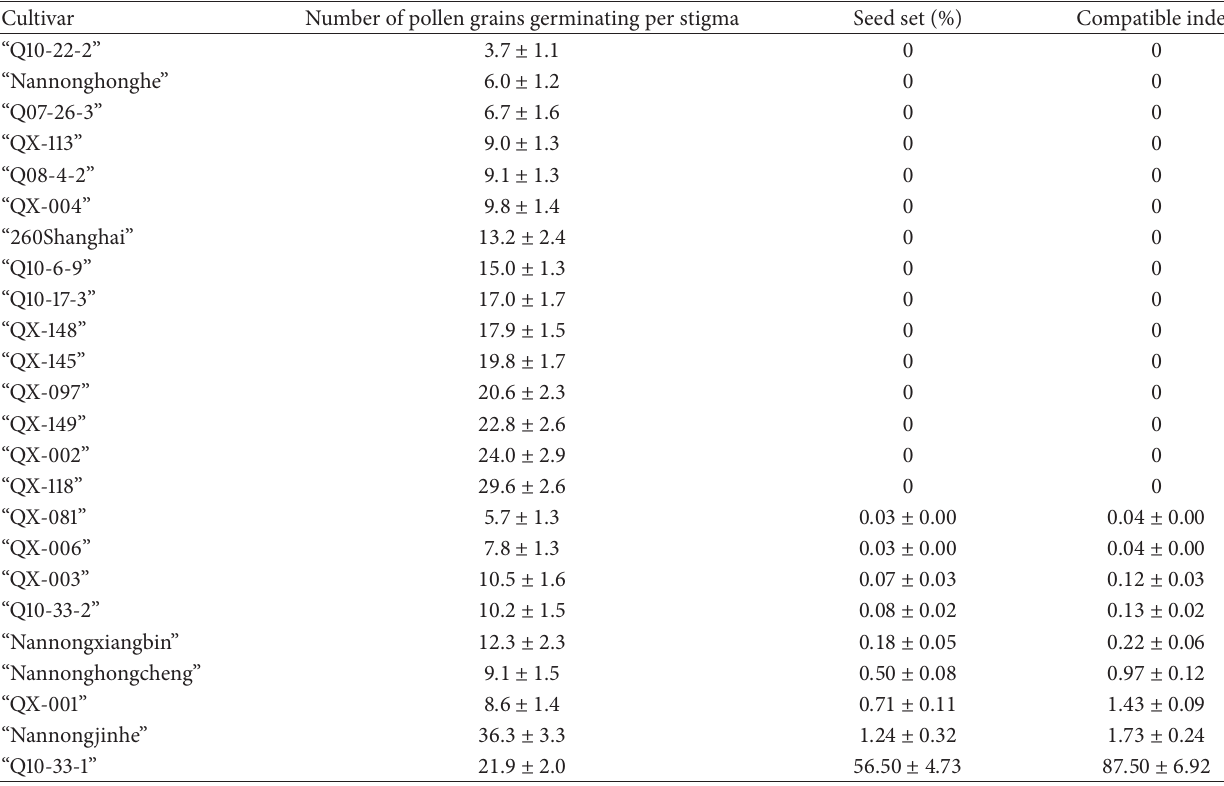
Table 1: Pistil receptivity, seed set, and compatible index of 24